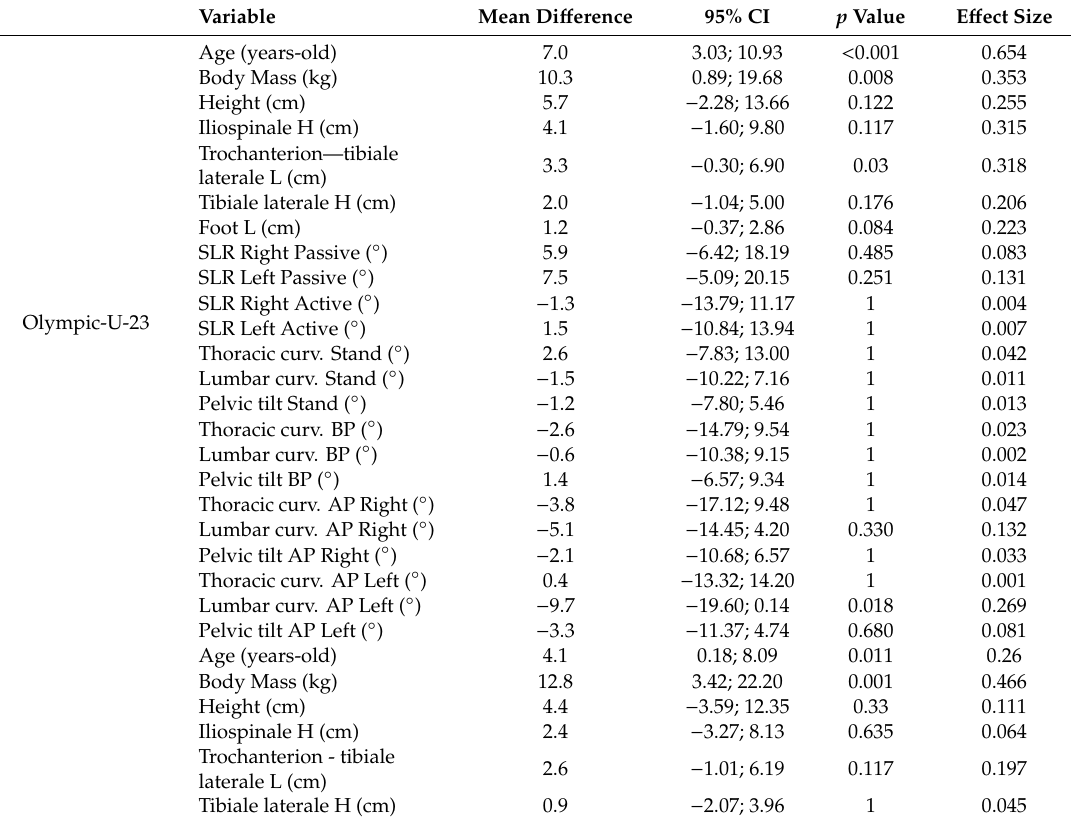
Table 2. Inter-group di ff